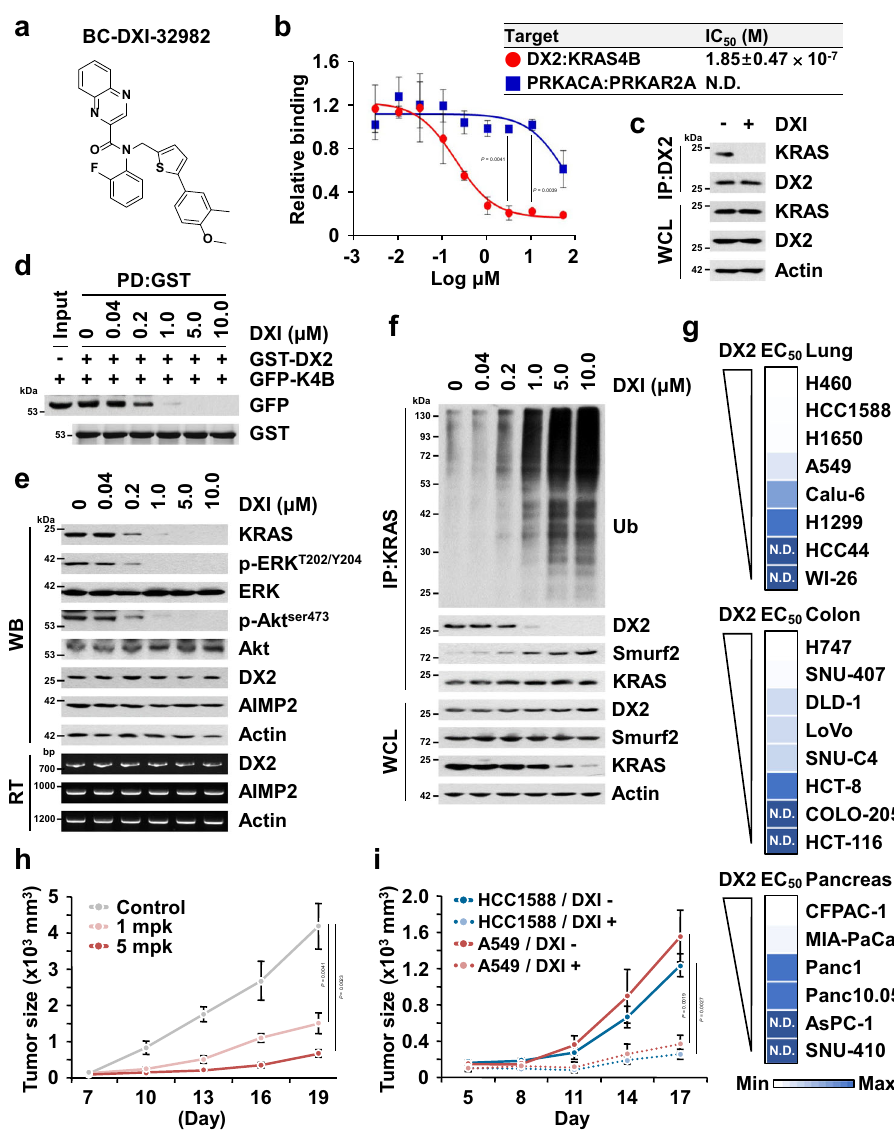
Fig. 5 Identi fi cation and characterization of BC-DXI-32982. a Structure of BC-DXI-32982 (DXI hereafter). b Inhibitory effect of DXI on the binding of DX2 and KRAS4B. Binding pair of PRKACA and PRKAR2A was used for checking the binding speci fi city. N.D. denotes “ not determined ” in the tested range of dose. The experiment was independently repeated thrice and error bars denote S.D. Data are presented as mean values± S.D. P value is from the two-sided t test. c Endogenous immunoprecipitation showing the interaction between DX2 and KRAS in H460 cells treated with DXI. Results are representative of at least three independent experiments. d In vitro pull-down assay showing direct inhibition of DXI on the binding of DX2 and KRAS4B. DXI was incubated with the mixture of cellular extracts expressing GFP-KRAS4B and the puri fi ed GST-DX2 proteins. Results are representative of at least three independent experiments. e Suppression of KRAS level via DXI. H460 cells treated with various concentration of DXI for 18 h were subjected to immunoblotting and RT- PCR. Results are representative of at least three independent experiments. f Ubiquitination assay analyzing DXI-mediated ubiquitination of KRAS. Results are representative of at least three independent experiments. g Heat map showing EC 50 of DXI on lung, colorectal, and pancreatic cancer cell lines expressing different levels of DX2 (Supplementary Fig. 12a). In each type of cancers, the maximum and minimum EC 50 values were represented as blue color with the highest and lowest intensity, respectively, and the rests were graded according to their relative values. h , i In vivo ef fi cacy of DXI on tumor growth. Mice ( n = 3) xenografted with H460 cells were intraperitoneally injected with DXI (1 or 5 mg/kg) fi ve times in 12 d ( h ). Mice ( n = 6) xenografted with HCC1588 or A549 cells were intravenously injected with DXI (5 mg/kg) fi ve times during the experiment ( i ). All error bars represent the standard deviation (S.D.). P value is from the two-sided t test. Source data are provided as a Source data fi